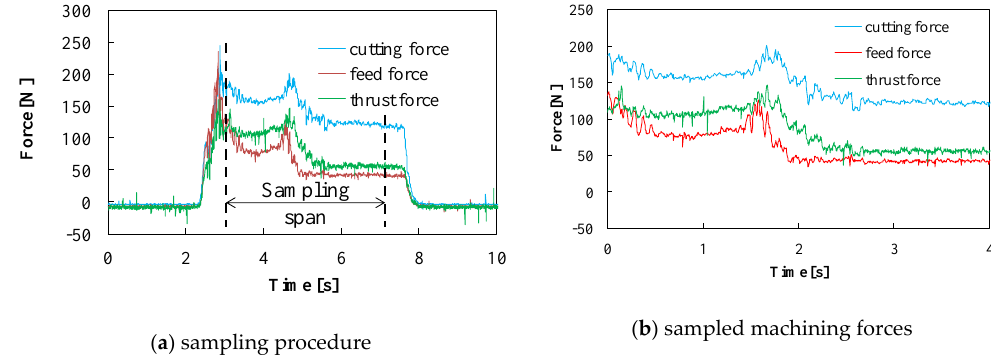
Figure 3. Force data after sampling.